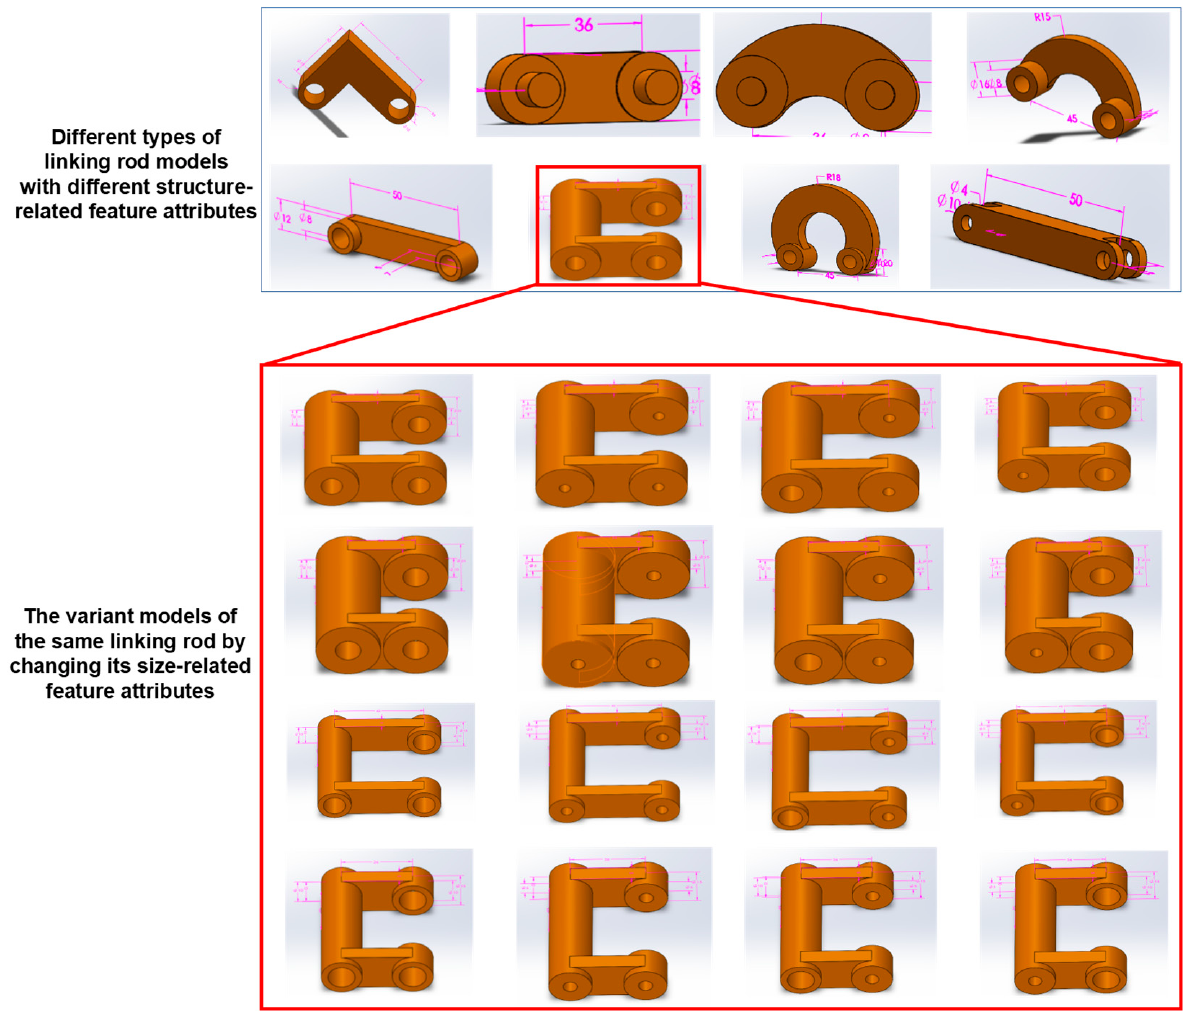
Figure 4. Examples of the 3D shape models in the training set.